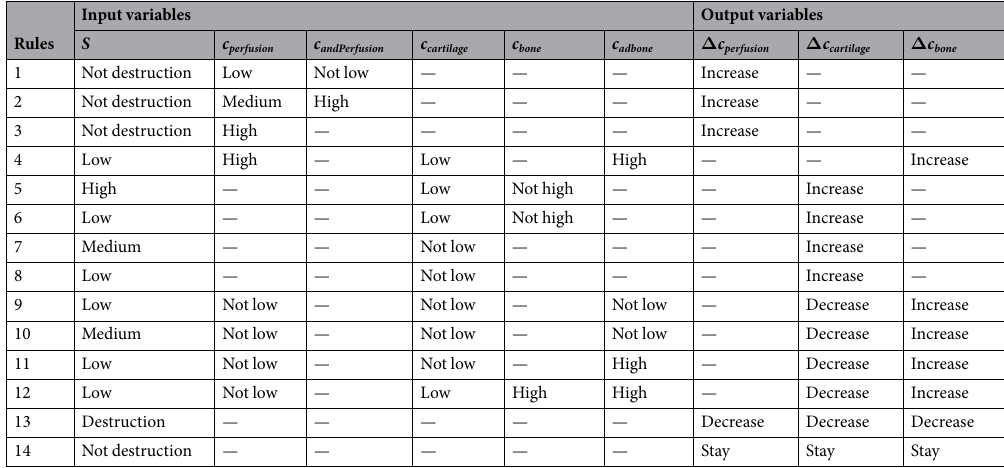
Table 4. Fuzzy logic rules for tissue differentiation within callus region. Note: “—” represent the current variable doesn’t participate in this rule. S represents the biophysical stimulus of current element. c perfusion represents the perfusion concentration of current element. c adPerfusion represents the highest perfusion concentration of adjacent elements of current element. c cartilage represents the cartilage concentration of current element. c bone represents the bone concentration of current element. c adbone represents the highest bone concentration of adjacent elements of current element. Δ c perfusion represents the change of perfusion concentration of current element. Δ c cartilage represents the change of cartilage concentration of current element. Δ c bone represents the change of bone concentration of current element.